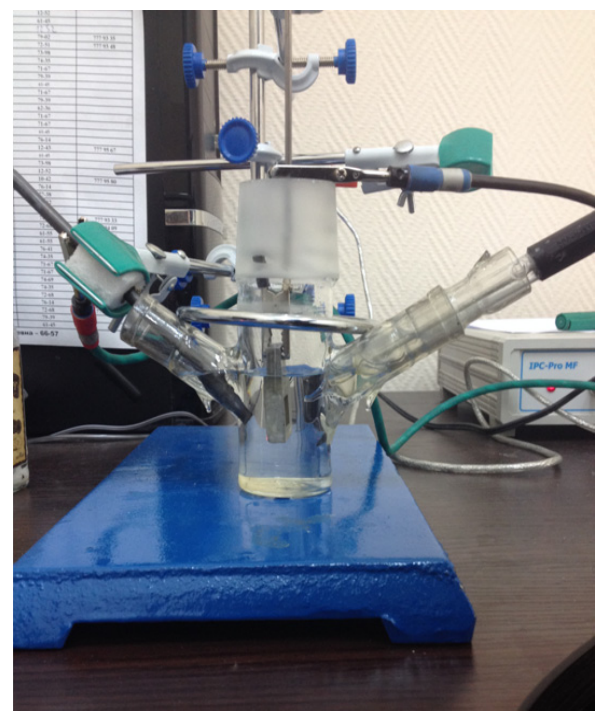
Figure 1. View of the electrochemical cell.